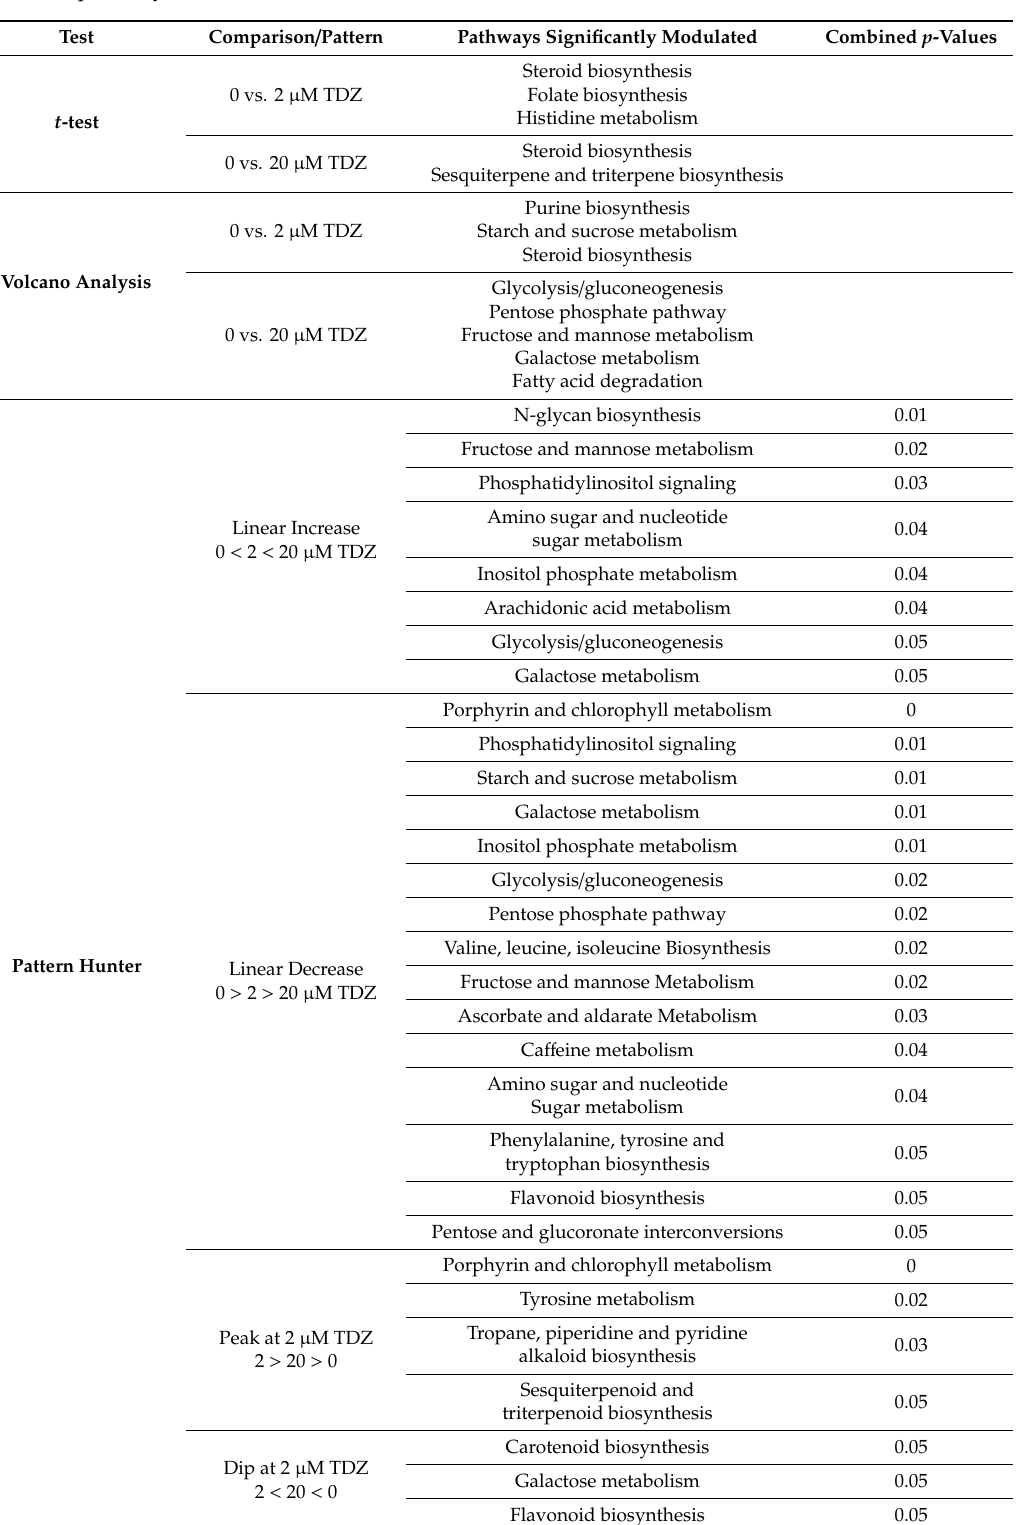
Table 4. Results of pathway analysis results for African violet petiole cultures treatment with 0 vs. 2 µ M thidiazuron (low TDZ) and 0 vs. 20 µ M thidiazuron (high TDZ). To provide an overall picture of metabolic pathways modulated by treatment results of pairwise t-test and volcano analysis or Pattern Hunter analysis was used as the input for pathway analysis by mummichog and GSEA (t-test only) in peaks to